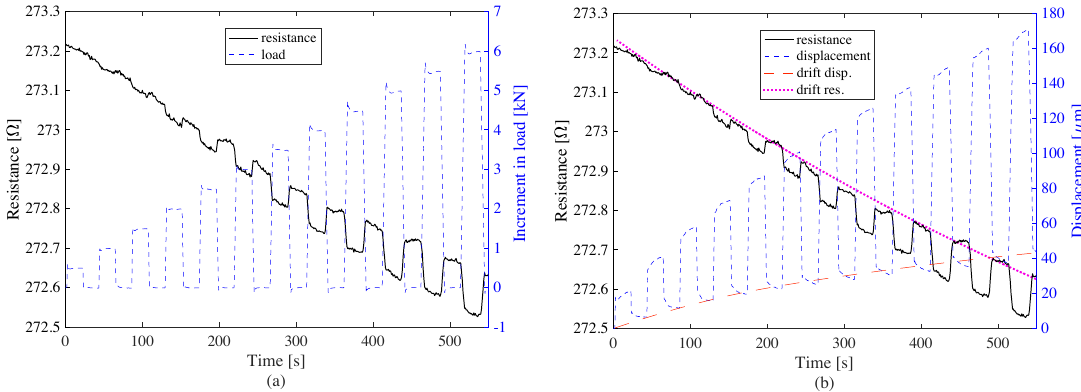
Figure 12. Raw time histories of electromechanical test with increasing box loads: ( a ) resistance versus increment in load; ( b ) resistance versus displacement of the top of the